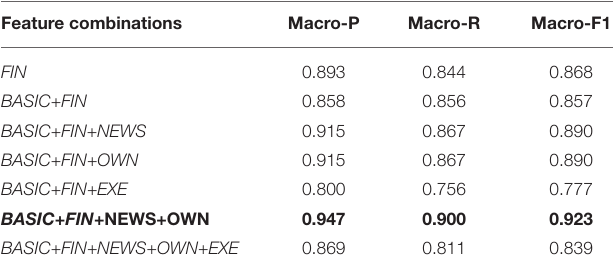
TABLE 9 | Comparison of different feature